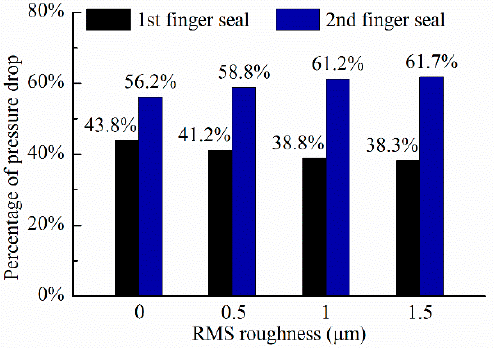
Figure 18. Effect of side leakage flow on the inter ‐ stage pressure drop characteristics.